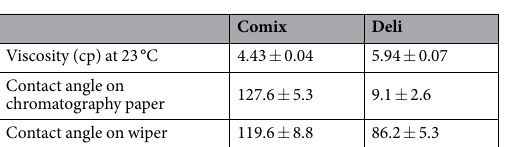
Figure 4. Investigating the effect of plotting speed and pattern dimensions. Testing the water-resistant capability of the patterns by yellow aqueous solution at different plotting speeds, markers, and number of passes on ( a ) Chromatography paper and ( b ) its summarized results as a performance chart. ( c ) Comparing different plotting speeds, markers, and number of passes on delicate task wiper. ( d ) Testing different plotting speeds and pattern dimensions with Comix fine-tip marker on delicate task wipers with a single pass. ( e ) A sample of an image processed pattern used for repeatability assessment. ( f ) Deviation of the plotted pattern from the center of the plotter origin.